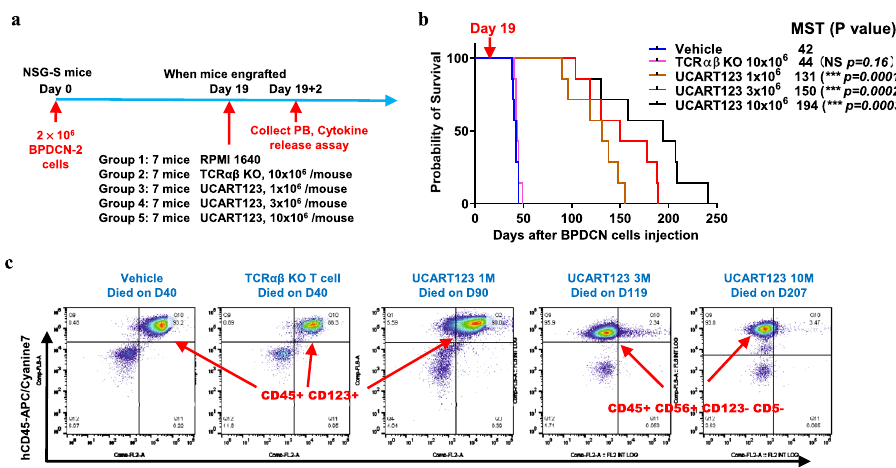
Fig. 5 Loss of CD123 leads to escape from UCART123 therapy and causes early relapses. a NSGS mice were injected with cells from a primary BPDCN sample (BPDCN-2) to create a xenograft experiment (PDX-3). After documenting engraftment on day 19 (0% circulating BPDCN, 13.9% and 33.8% engraftment in bone marrow from 2 mice), mice were randomized into 5 treatment groups (n = 7 mice/group) and were treated as follows: vehicle; 10 × 10 6 TCR αβ KO T cells; 1 × 10 6 UCART123 cells; 3 × 10 6 UCART123 cells; or 10 × 10 6 UCART123 cells. b Survival of mice in the treatment groups was estimated by the Kaplan-Meier method. Red arrow indicates start of treatment (Day 19). MST = median survival time (in days). Signi fi cance was determined using unpaired two-tailed t-test annotated as “ NS ” (not signi fi cant, p ≥ 0.05 ), ***P ≤ 0.001 . c Expression of CD123 on tumor cells isolated from bone marrow of control or UCART123-treated mice at the time they were sacri fi ced due to excessive tumor burden. Tumor cells from control mice co- expressed CD123 and CD56, while in UCART123-treated mice, tumor cells lost CD123 expression (CD123 - ) but remained CD56 + . M = million. Source data are provided as a Source data fi le.